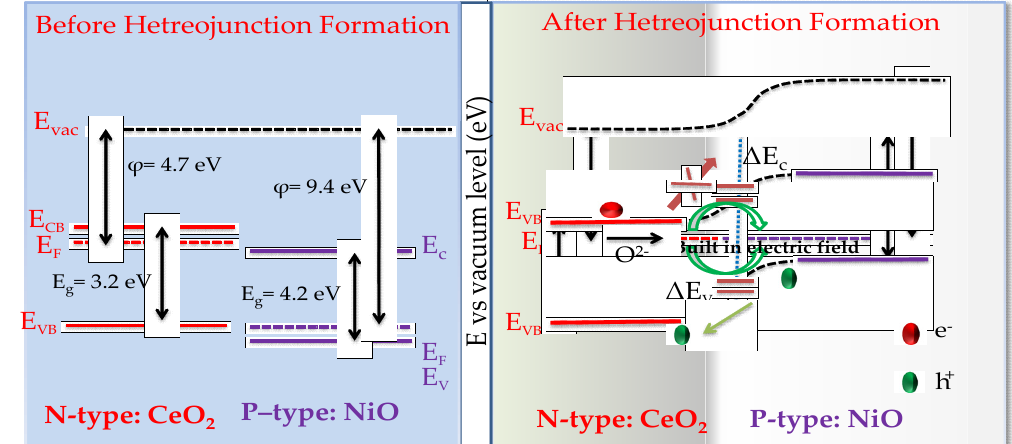
Figure 8. The band structure of CeO 2 -NiO heterostructure composites.